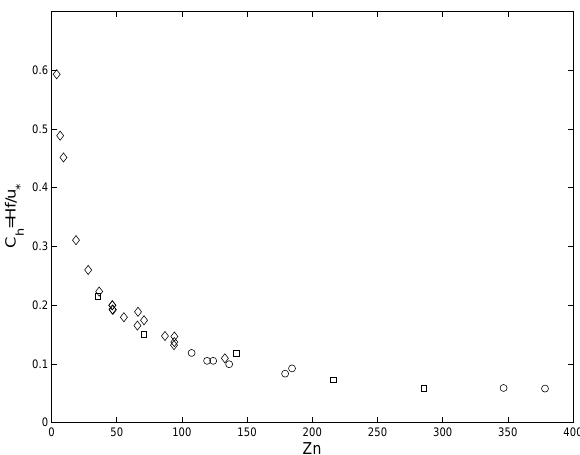
Fig. 1. The dependence of the normalized depth, C h = H | f | /u ∗ , of the conventionally neutral PBL on the stratification of the free atmo- sphere above the PBL. The strength of the stratification is expressed through the Zilitinkevich number, Z n . Data is taken from the au- thor’s LES database. Squares, circles and diamonds denote individ- ual LES runs with the log-layer more shallow than 20m, 50m and